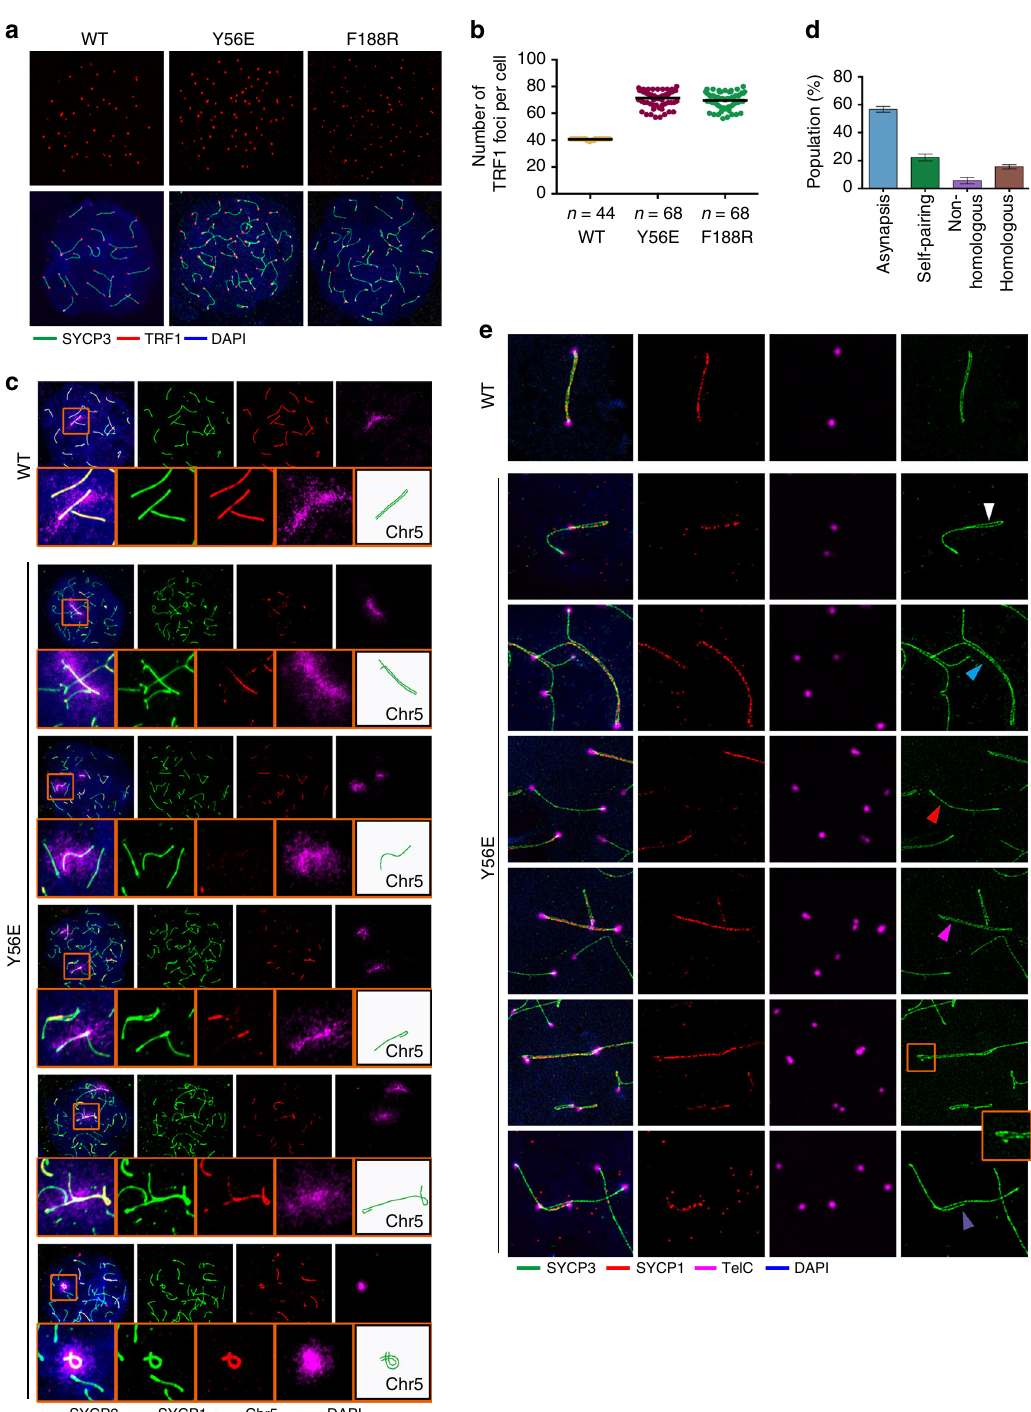
interaction between homologous chromosomes (Fig. 7e, f). This is consistent with the result of chromosome painting assays that most chromosomes are spatially separated from their homologs (Supplementary Fig. 6a – d). As expected, IF staining revealed no MLH1 foci in the mutant spermatocytes (Fig. 7g, h), suggesting a complete absence of crossover formation between homologous chromosomes. Collectively, our data demonstrated that disrup- tion of the TTM complex causes severe impairment of homo- logous recombination and persistent